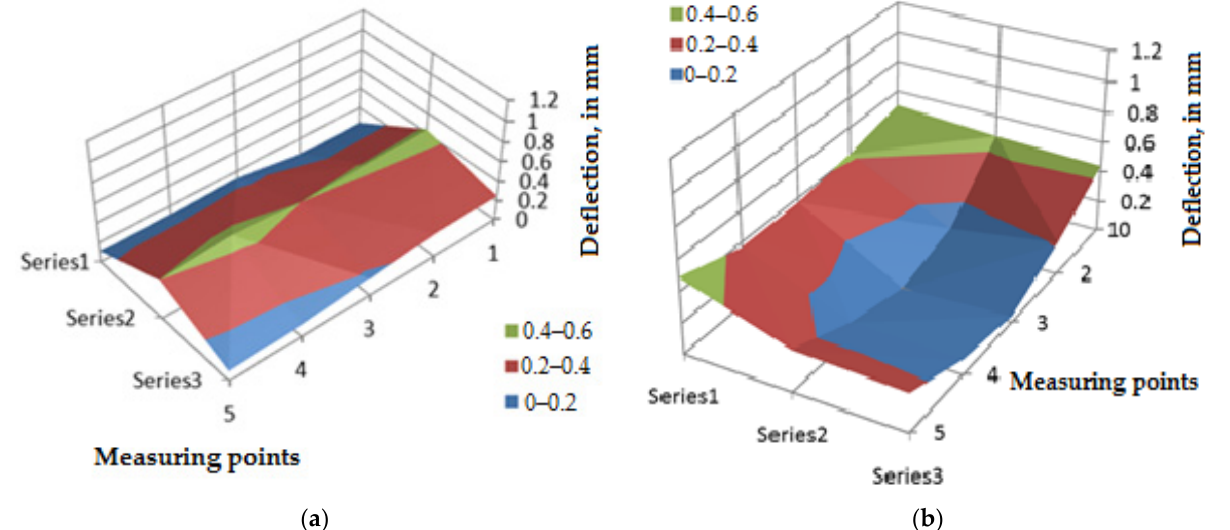
Figure 5. Deflection values and warpage of blockboard with veneer (V) faces tested in the kitchen: ( a ) at the beginning of the experiment; ( b ) after three months of exposure in the kitchen. Due to the frequent cyclical changes in RH between 50% and 90% programmed at 5 days, the panels tested in the climatic chamber absorbed more humidity from the environment than the ones tested in the kitchen and bathroom, where the changes in RH varied only between 25% and 64% for the kitchen and 43% and 88% for the bathroom but with aleatory changes, depending on the use of these spaces. This higher uptake of moisture from the climatic chamber explained the maximum deflection value of 0.59 mm recorded for the blockboards after three months of exposure in this cyclical climate